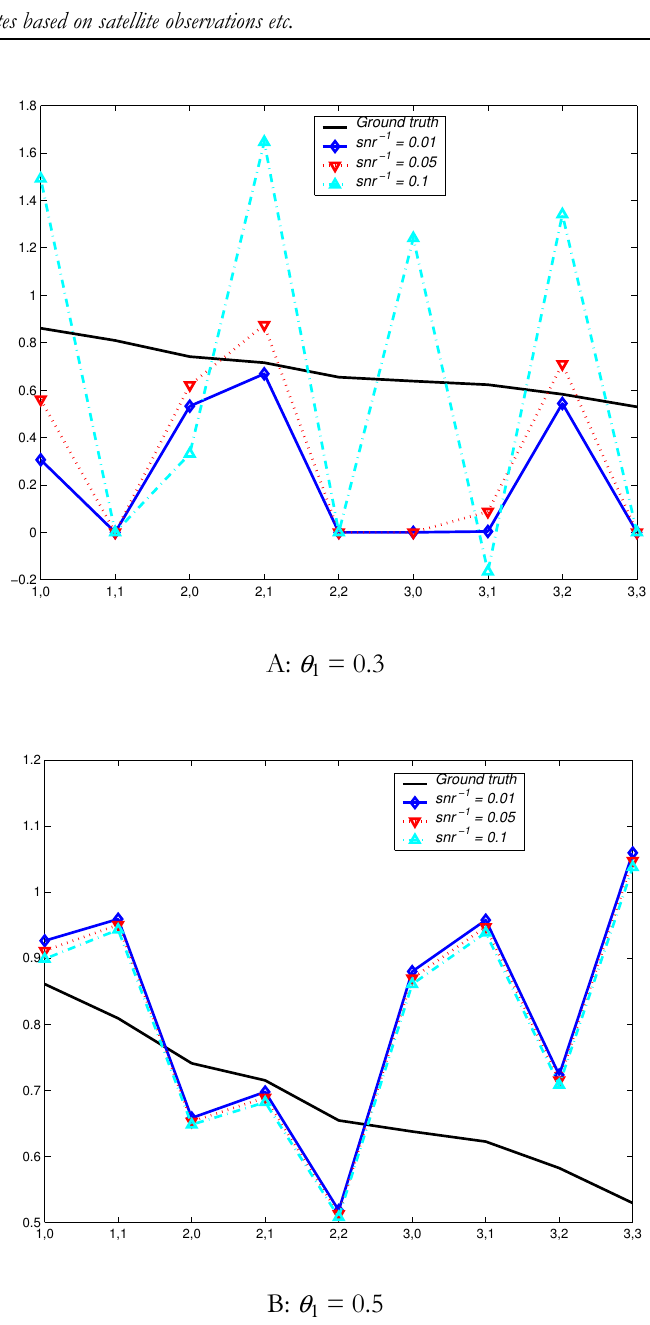
Figure 3 – Corrected correlation estimates for various values of location and attribute error parame- ters ( θ and snr ), under model (11), for the strong dependency case ( β = 0.15 in equation (12)). Cor- 1 relations are reported in the graph for spatial lags ( k , h ), k , h = 0, ..., 3, when snr –1 =0.01, 0.05, 0.1, θ = 0.5 (Plot = 0.3 (Plot A), and θ 1